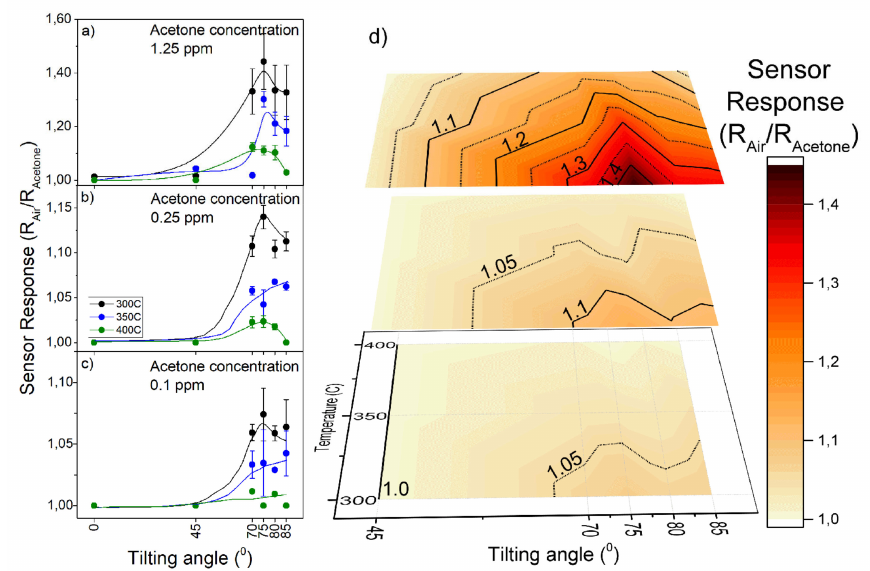
Figure 11. Sensor response for di ff erent concentrations of acetone: 1.25 ppm ( a ), 0.25 ppm ( b ), and 0.1 ppm ( c ) and di ff erent working temperatures (300 black, 350 blue, and 400 ◦ C green). Representation of the data in the form of maps can be found on the right side of the graph ( d ).